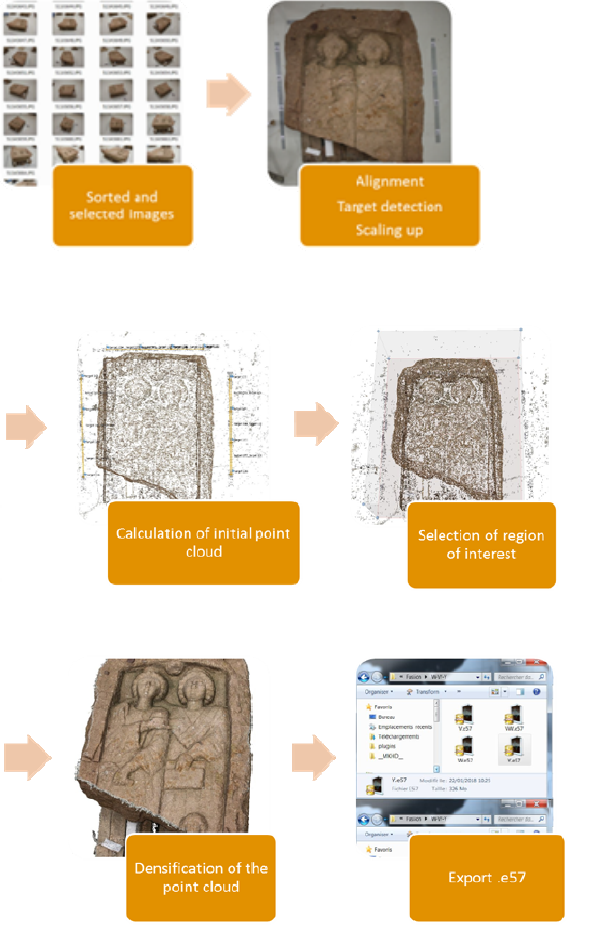
Figure 14: Workflow in Metashape